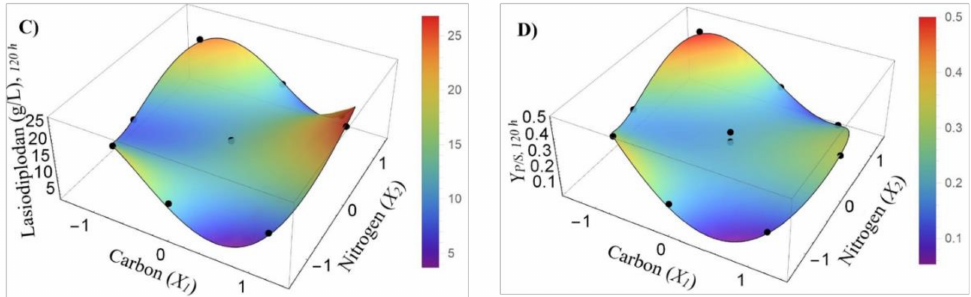
Figure 4. SCBCH and SBE interaction for lasiodiplodan production: ( A ) Production at 96 h; ( B ) Yield at 96 h; ( C ) Production at 120 h; ( D ) Yield at 120